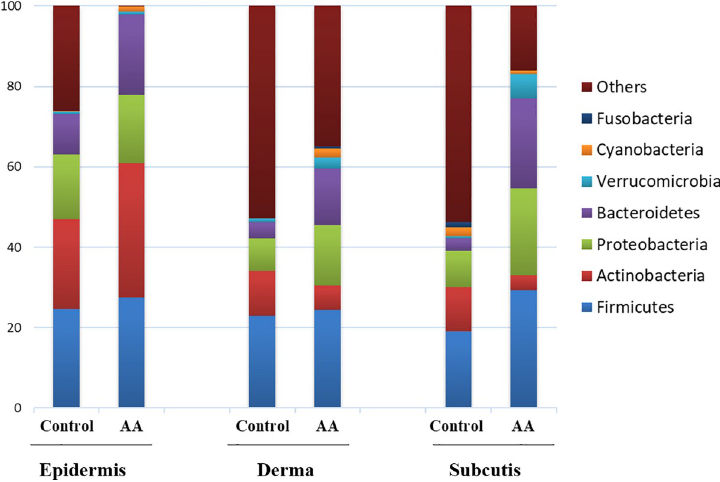
Fig 3. Bacterial profiling of scalp biopsy samples from control and AA subjects. % of bacteria at phylum level in the control and AA groups in the epidermis, dermis and hypodermis. Results are presented as the percentage (%) of total